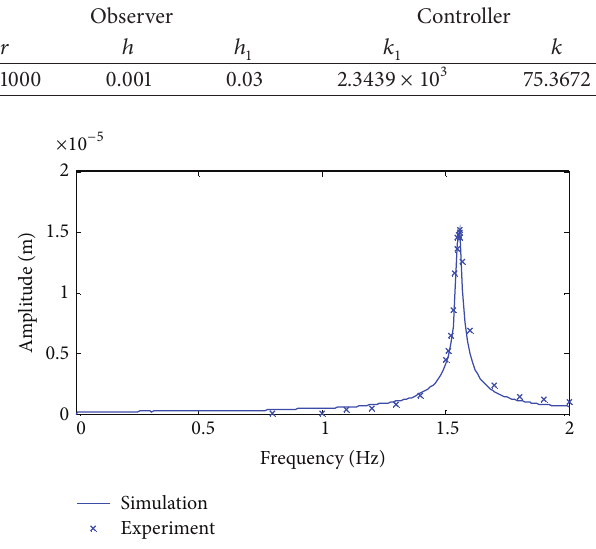
Table 2: Corresponding parameters of observer and controller. Observer